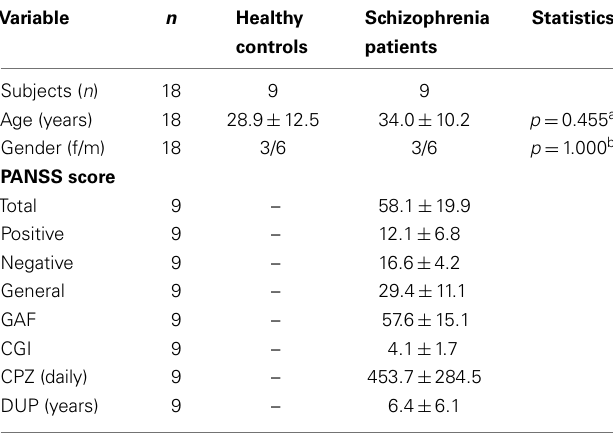
Table 1 | Demographic and clinical characteristics of the subjects.